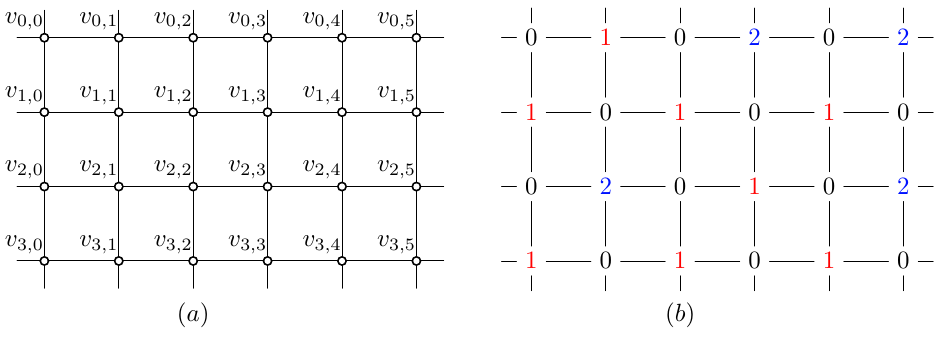
Figure 1. The graph of C 4 (cid:3) C 6 ( a ) and an OIRDF on C 4 (cid:3) C 6 ( b